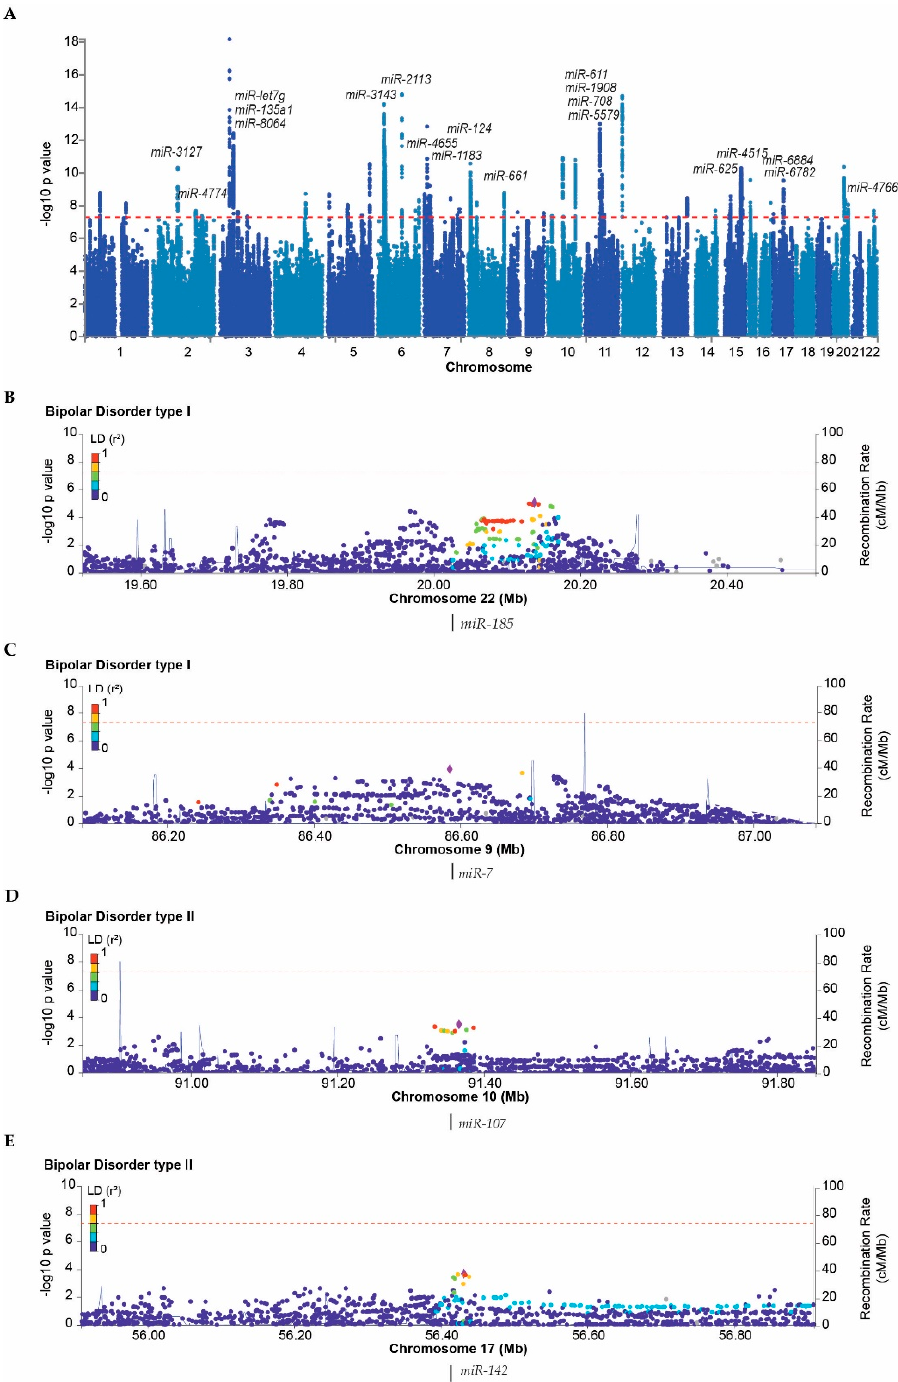
Figure 2. Genetic association to BD in miRNA-harboring loci. ( A ) Manhattan plot showing 64 genome-wide significant (GWS) loci identified in the, to date, largest GWAS on BD samples. miRNA- encoding genes located within each GWS locus are listed above loci. ( B , C ) Regional association plots for BD type I: ( B ) miR-185 locus ( C ) miR-7 locus, and ( D , E ), and for BD type II: ( D ) miR-107 locus and ( E ) miR-142 locus. The purple diamond indicates the most significant single-nucleotide poly- morphism (SNP) of each region, and nearby SNPs are color-coded to show their LD relationships with the top SNP (r 2 < 0.2, dark blue; 0.2 ≤ r 2 < 0.4, light blue; 0.4 ≤ r 2 < 0.8, green; r 2 > 0.8, red) based on Hapmap3 EUR. Dotted line marks GWS cutoff.